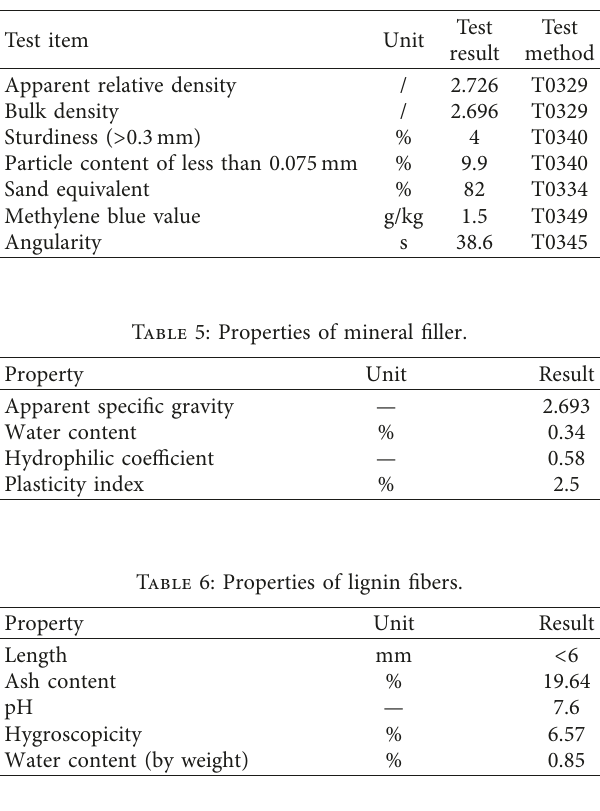
Table 4: Properties of fine aggregate.